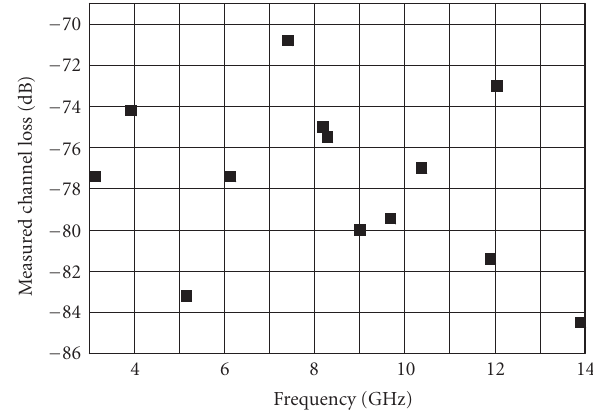
Figure 12: Measurement results of the intrabody channel